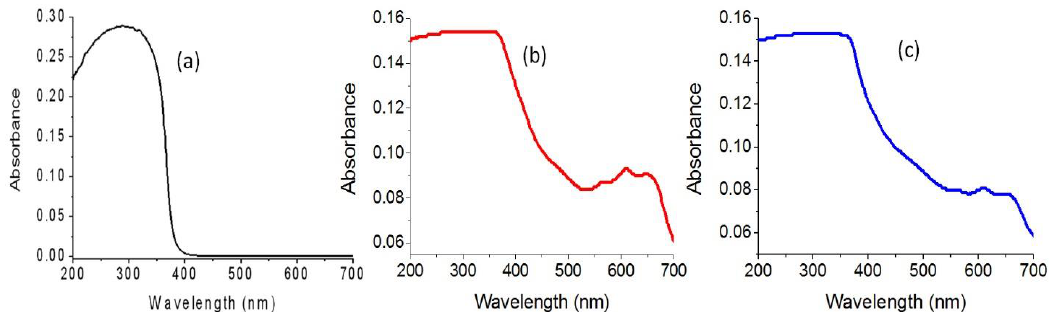
Figure 10. UV-Vis absorbance of ( a ) ZA-500, ( b ) NHZ-1-500, and ( c ) NHZ-2-500. This finding was confirmed by calculating their band gap energy through a Tauc plot [44 – 46]. The band gap energy was determined by plotting the relation between (αhν) 2 and energy (hν) as shown in Figure 11. The band gap energy E g of ZA-500 was calculated by extending the straight line to the (hν) axis to obtain the optical band gap energy at (αhν) 2 of 0. This showed 3.10 eV indicating a little shift from the band gap of pure ZnO (3.295 eV) [45] because the doping of aluminum inside the zinc oxide structure caused two competing mechanisms [44,45]; there are band gap widening (BGW) and band gap narrowing (BGN). BGN is a consequence of many body effects on the conduction and the valence bands; narrowing is counteracted by the Burstein – Moss effect, which provides BGW as a result of blocking of lowest states in the conduction band. For a lightly doped semiconductor, the filling of the conduction band leads to BGW. Burstein – Moss provided the band gap broadening in an n-type semiconductor. On the other hand, for higher donor density, band gap narrowing becomes significant [46]. This phenomenon, which affects the optical absorption edge more with increasing donor density, is due to many body effects such as exchange energy due to electron – electron and electron – impurity interactions. These effects lead to a narrowing of the band gap (red shift). In this case, the total measured optical band gap, E g , is the net result of blue shift and red shift. Wolf [45] showed that the band gap red shift is predominant in heavily doped n-type semiconductors similar to our previous work [44] and the current study.